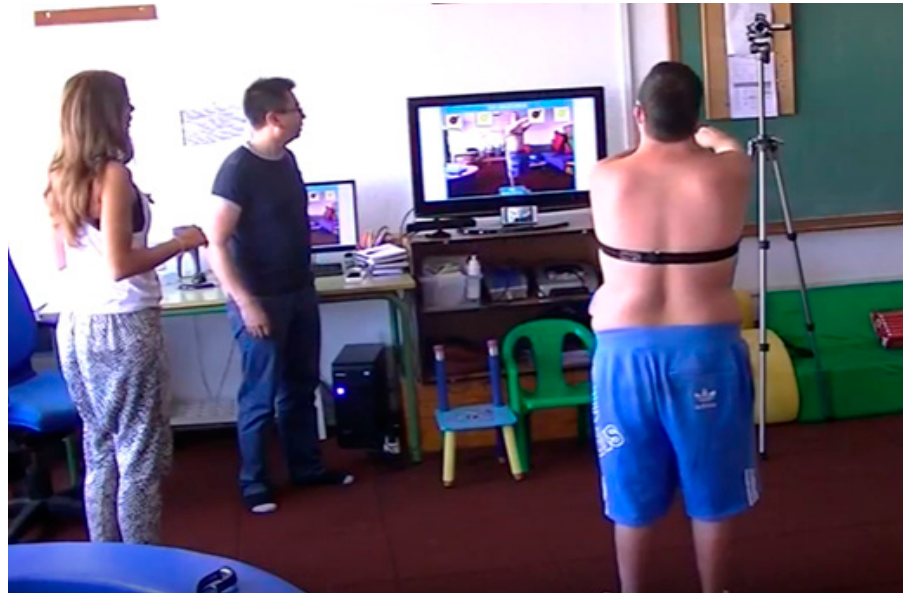
Figure 2. Uses of TANGO:H with individuals with Down syndrome in the Association Down Tenerife.